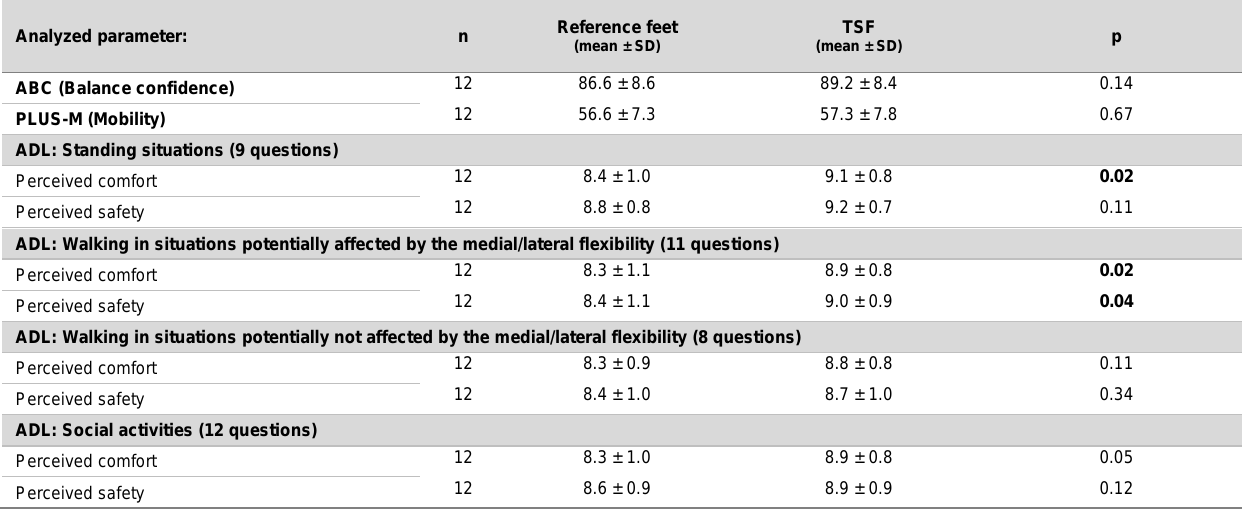
Table 4: Summary of the scores in the patient-reported outcomes for reference feet and the TSF. Significant differences in a parameter are marked bold for the p values (p<0.05). Analyzed